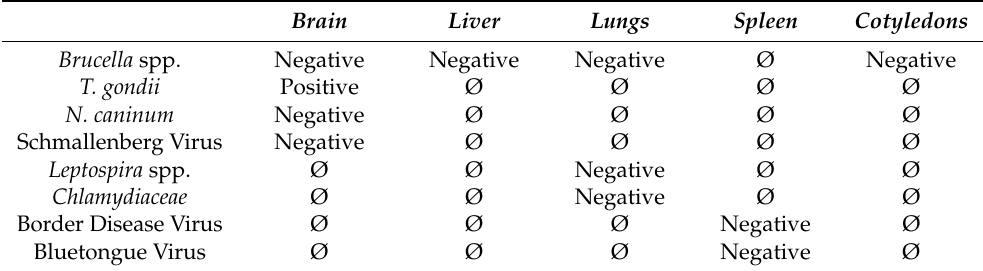
Table 4. Results of PCR testing of fetus. Ø = Not